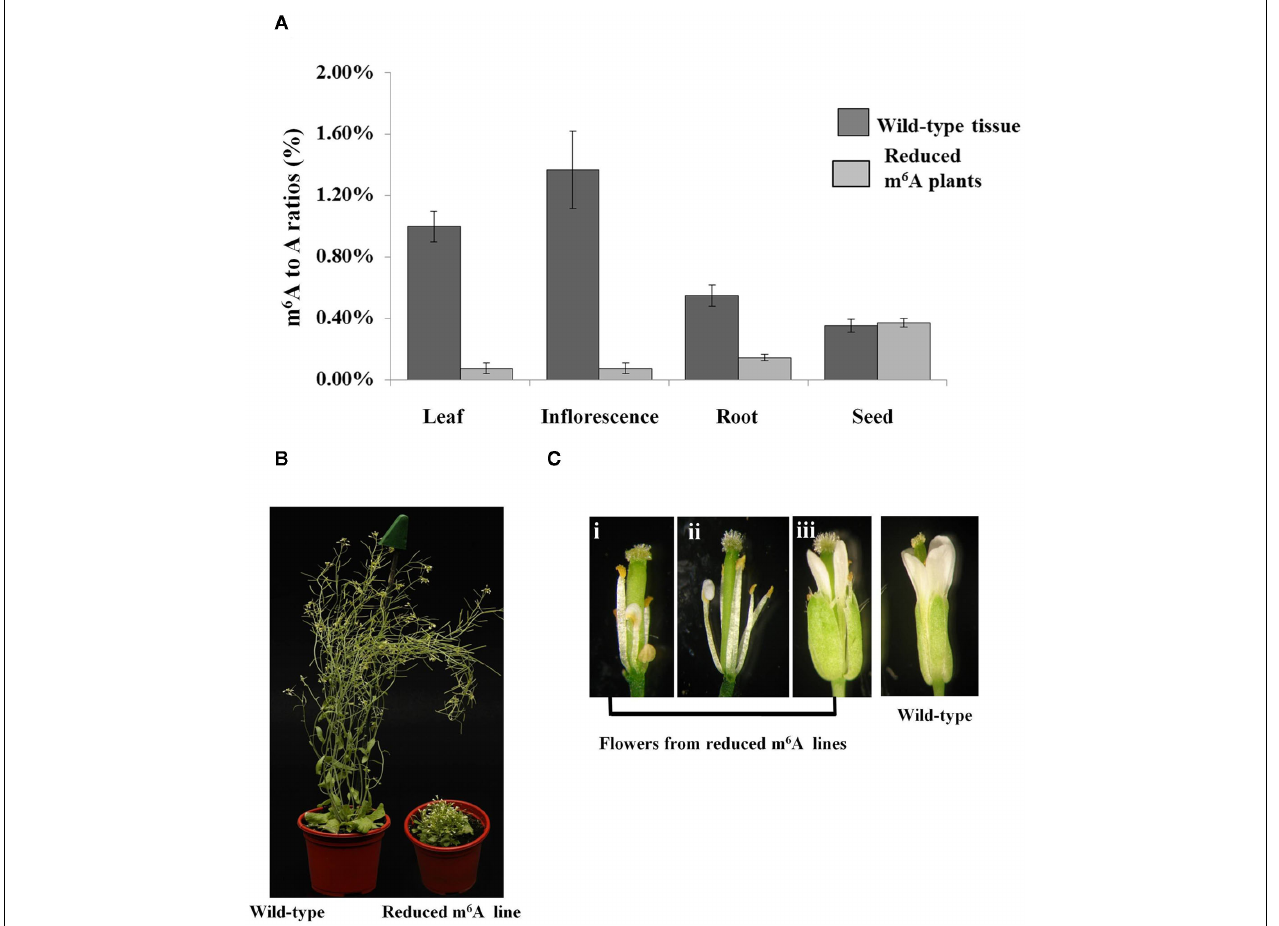
the leaves and flowers of the SALK_074069 ABI3MTA transgenic lines (A) . Plants with reduced levels of m6A are more compact, have leaf crinkling, shorter inflorescence, and reduced apical dominance (B) . Floral defects are common in the reduced m6A plants. Some stamens show partial conversion to petals [ (i,ii) , sepals and petals removed for clarity] and organ order is also sometimes affected (iii) (C)